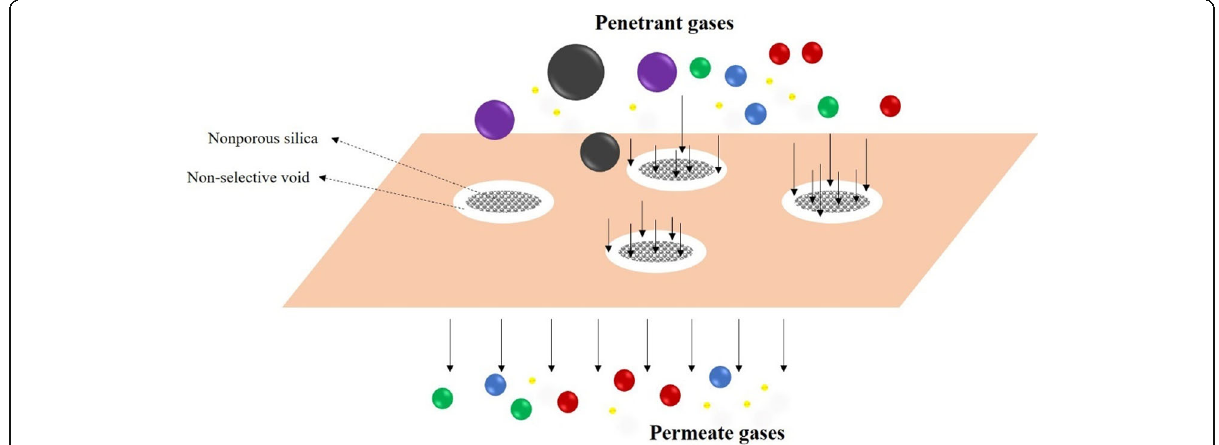
Fig. 8 Gas transport mechanism of penetrant gases through MMMs containing mesoporous silica with non-selective